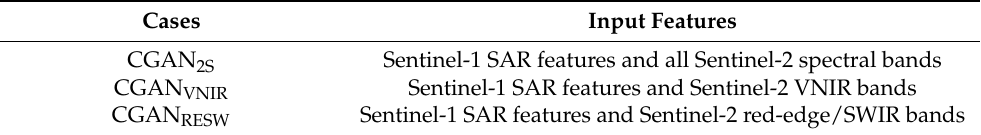
Table 6. Comparison cases for virtual Sentinel-2 image